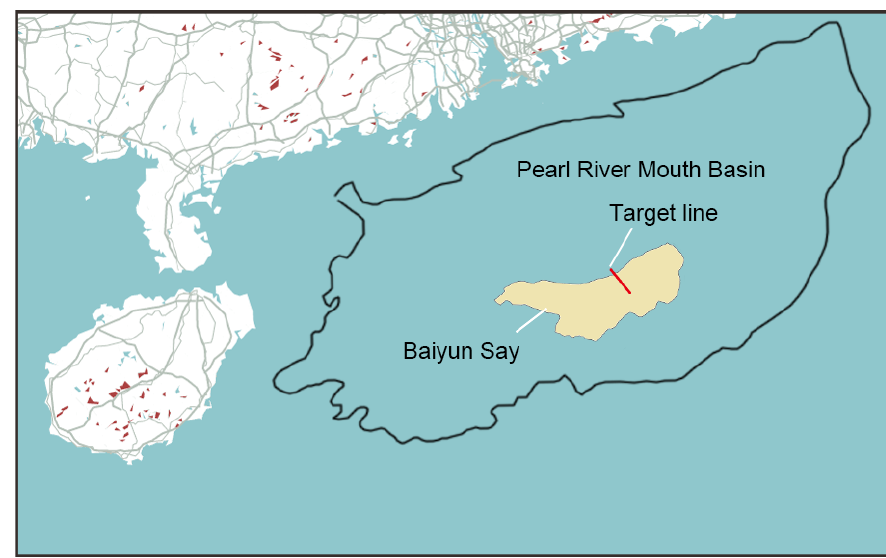
Figure 2. Location of the studied area. The red line indicates the location of the 2D seismic line that was used to build the geological model in Figure 3.